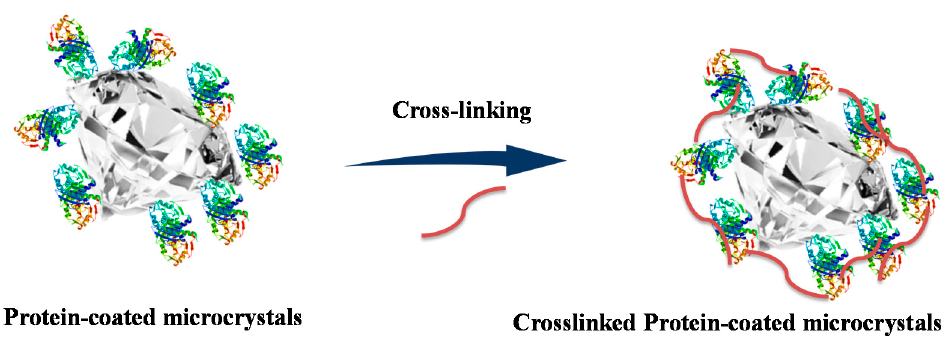
Figure 7. Schematic representation of the production of CLPCMC.